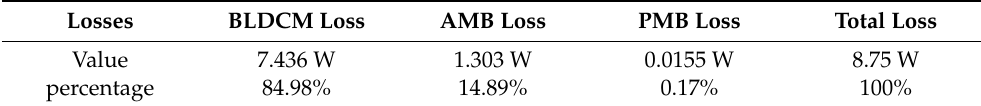
Table 12. Loss percentage of the different